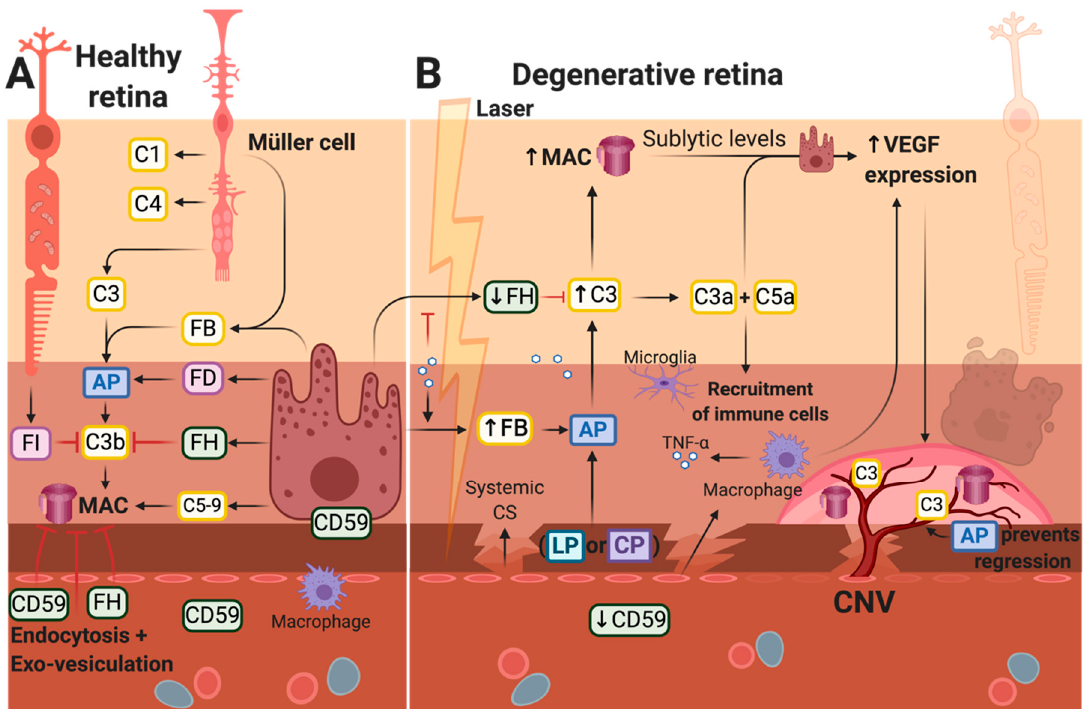
Figure 5. In vitro and in vivo studies indicate important roles for the AP, MAC, and the anaphylatoxins in CNV-formation. ( A ) In the healthy retina, complement activation and MAC-deposition in the RPE cells and CC are kept in check by inhibitors such as FH, CD59, and endocytosis [126]. ( B ) Shortly after laser-induction, the level of anaphylatoxins was found to increase [140], i.e., the complement system was activated. RPE cells in close proximity to the laser may degenerate directly due to coagulation necrosis, the following scar-formation, or CNV detaching the RPE from its source of nutrition. The activation of the complement system is pronounced in several cell layers of the outer retina and in the choroid. Therefore, it is not restricted to the specific regions shown above. AP, alternative pathway. CC, choriocapillaris. CNV, choroidal neovascularization. CP, classical pathway. FB, Factor B. FD, Factor D. FH, Factor H. FI, Factor I. LP, lectin pathway. MAC, membrane-attack complex. PR, photoreceptor. RPE, retinal pigment epithelium. TNF- α , tumor necrosis factor-alpha. VEGF, vascular endothelial growth